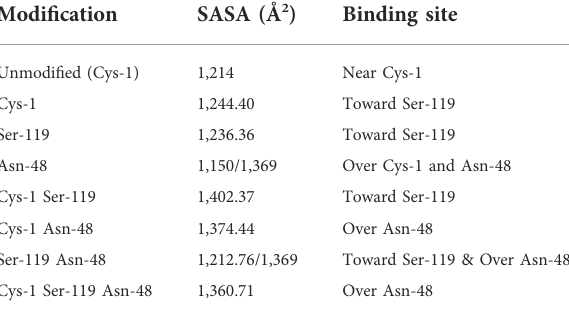
TABLE 5 SASA of ANS upon binding to formalin modi fi ed CHT (External